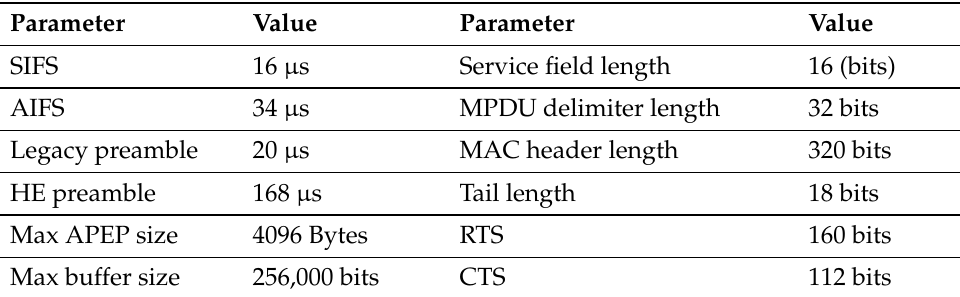
Table 1. IEEE 802.11ax simulation